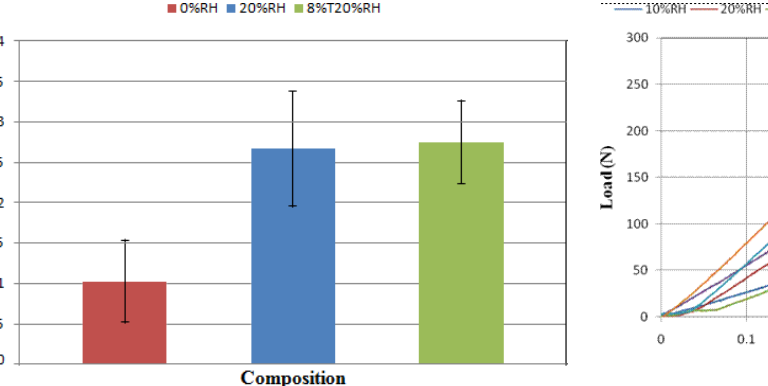
Figure 6: Load-deflection curve for various fracture specimens